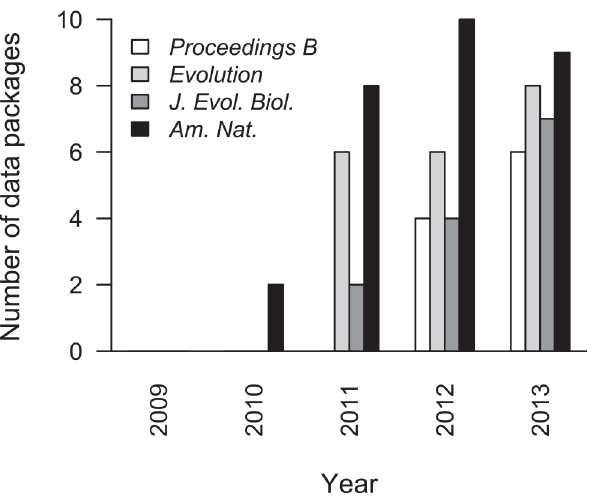
Fig 4. Publication dates of the 72 data packages from long-term study populations that were included in the survey.